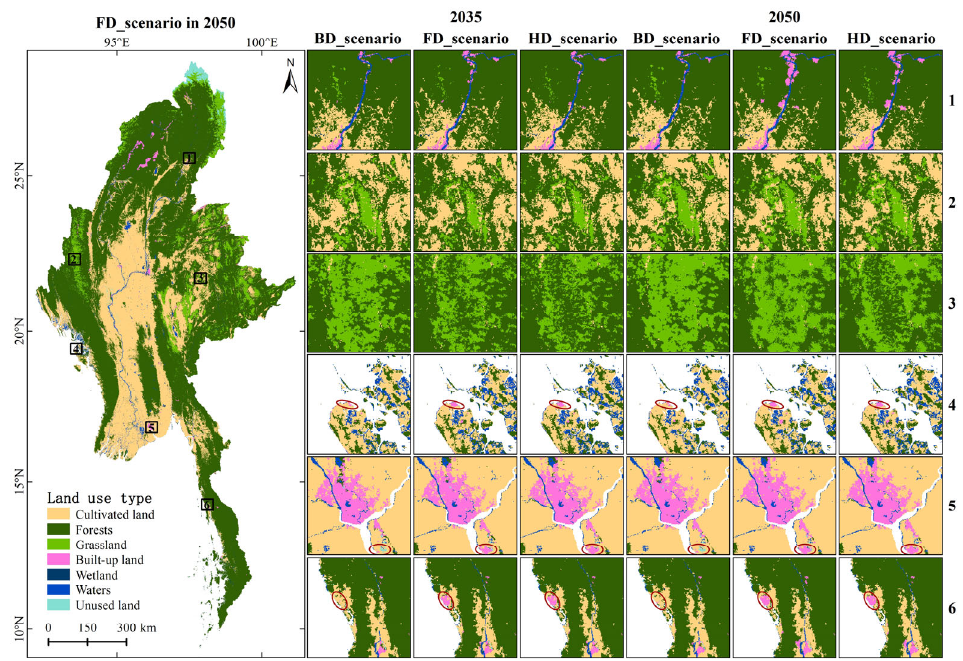
Figure 7. Local characteristics of the simulated land use patterns in the three designed scenarios in 2035 and 2050.